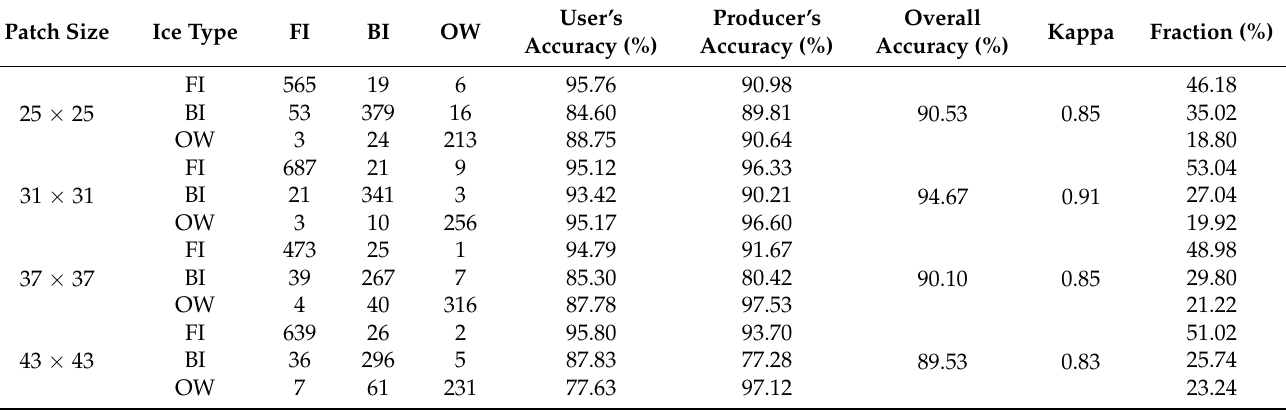
Table 2. Sea ice classification confusion matrix for the R3-15 scene data based on MSI-ResNet with patch sizes of 25 × 25, 31 × 31, 37 × 37, and 43 × 43. Patch